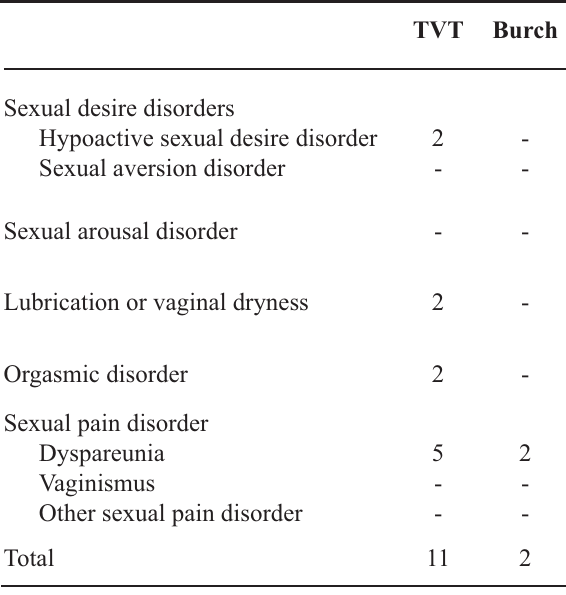
Table 2 – The reasons for dissatisfaction after TVT and